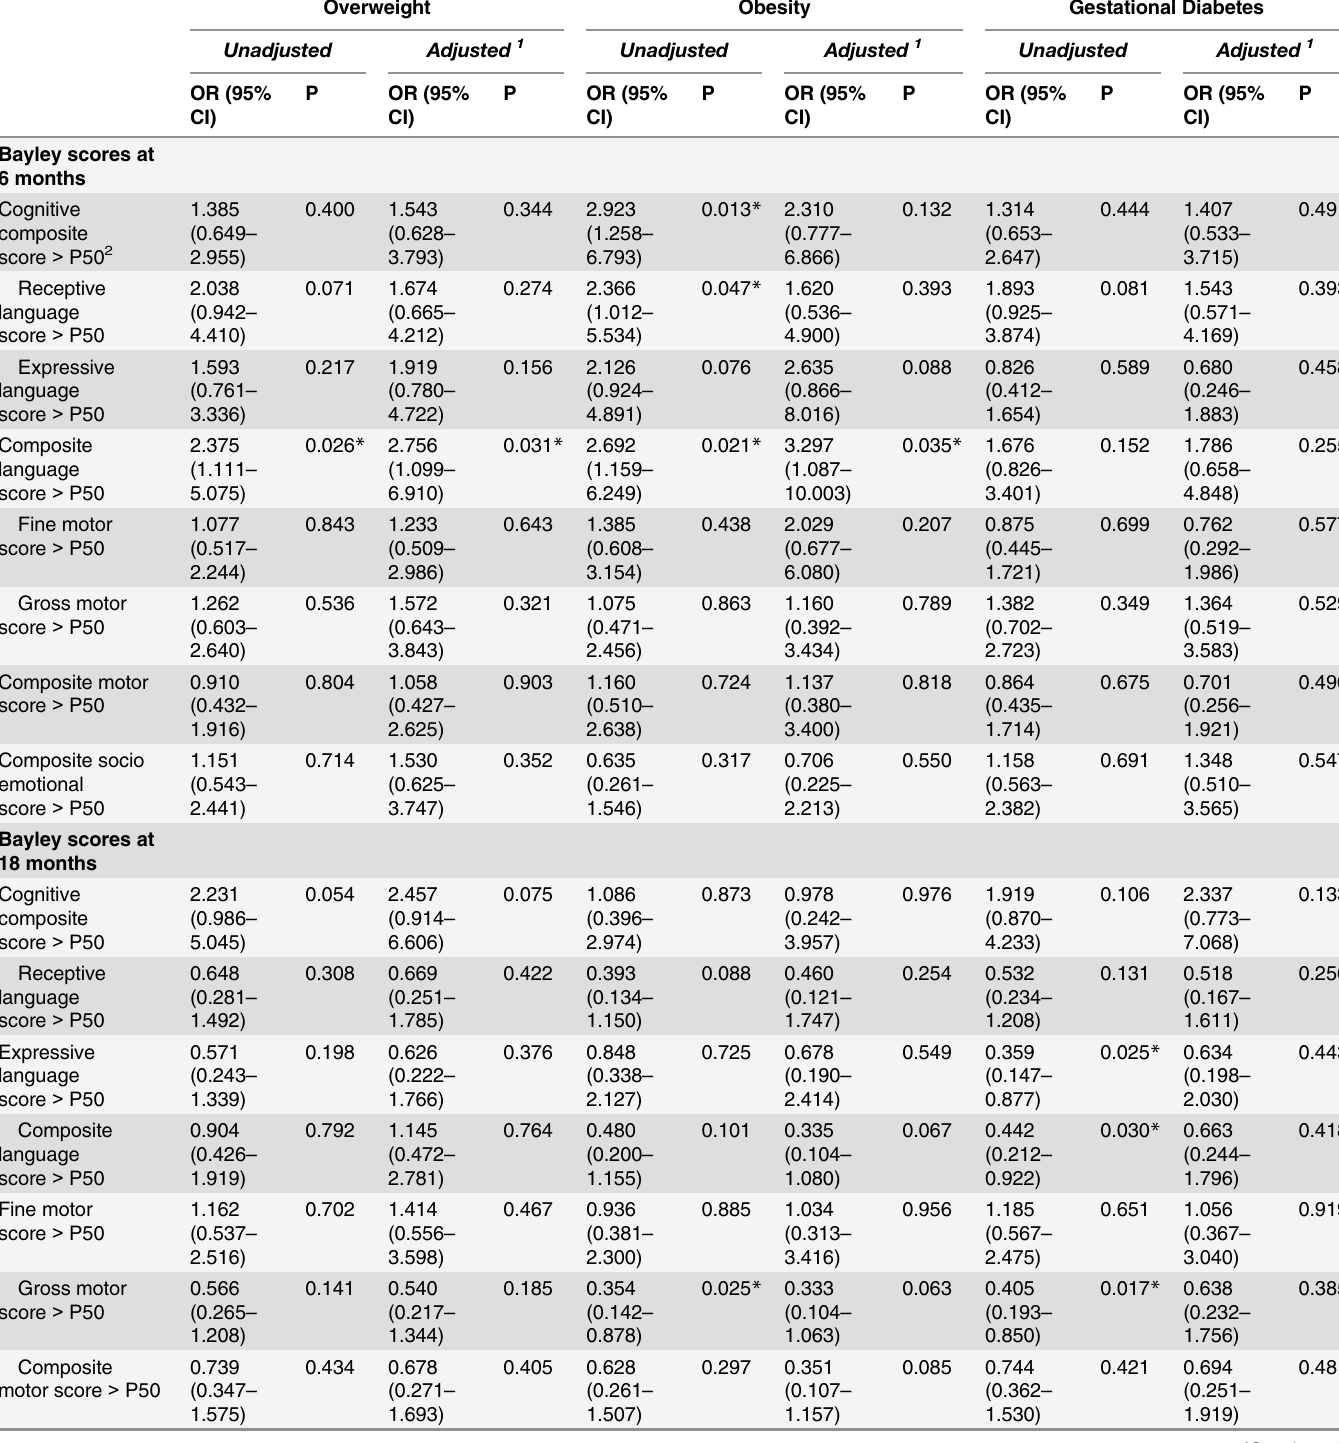
Table 4. Logistic regression models assessing the odds of having the different Bayley scale scores at 6 and 18 months of age above the median. ORs are presented for infants born to mothers with overweight, obesity and gestational diabetes respectively using infants born to mothers with normal weight and no gestational diabetes as